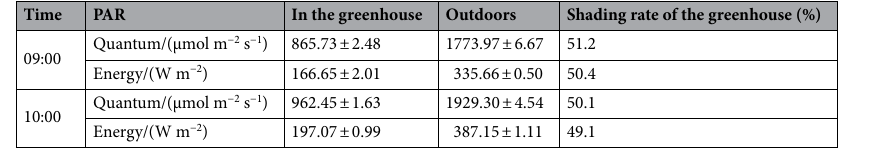
Table 1. The PAR both in the greenhouse and the outdoor on a sunny day, and the calculated shading rate of the greenhouse.